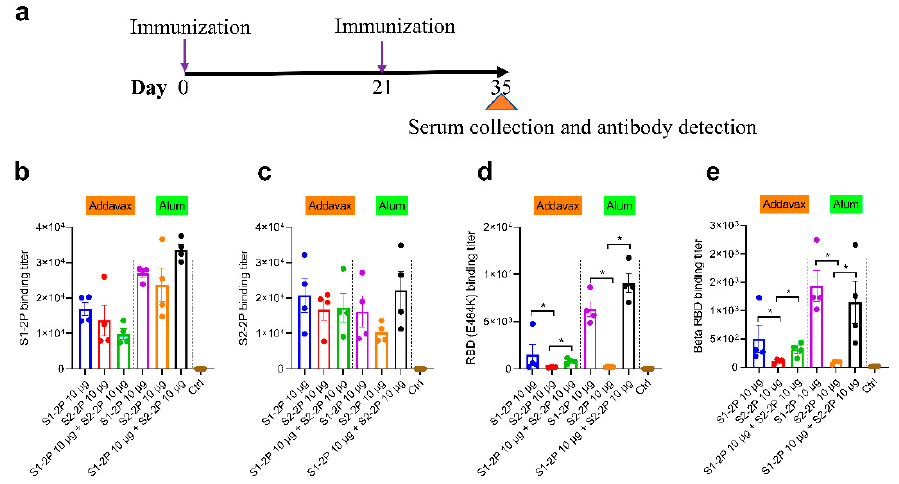
Figure 2. Humoral responses of immunized mice at 10 µ g dose. ( a ) Schematic of mouse vaccination. S1-2P-specific IgG titer ( b ), S2-2P-specific IgG titer ( c ), E484K RBD-specific antibody titer ( d ), and Beta RBD-specific antibody titer ( e ) of immunized BALB/c mice were determined by ELISA. The dots of different colors represented mouse serum of different immune groups. The data were represented as the reciprocal of the serum dilution that led to a half-maximal binding signal. Statistical significance was determined using one-way ANOVA or t -test and is indicated as * for p < 0.05.